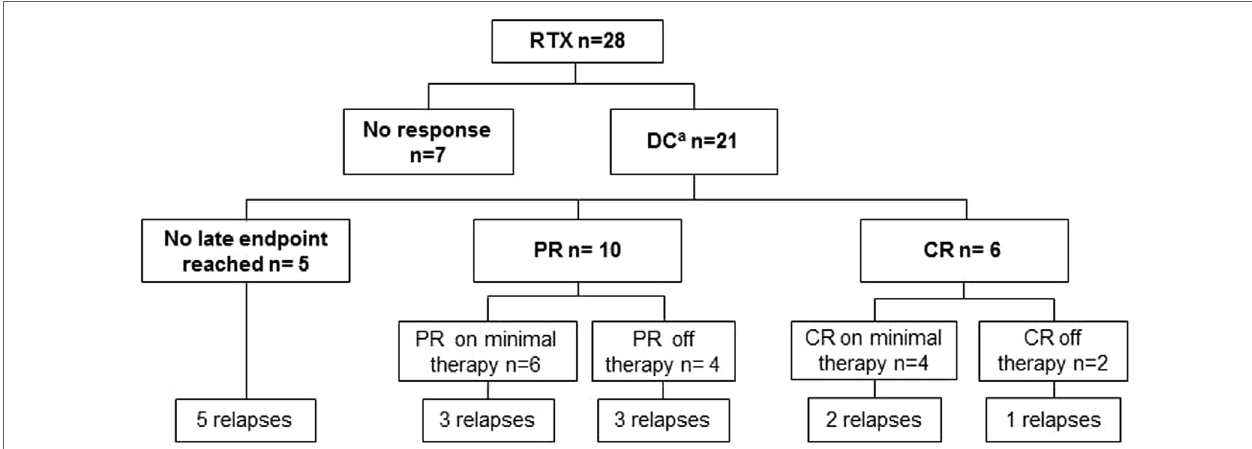
FigUre 3 | Flowchart of the effectiveness of RTX in pemphigoid patients, showing the highest endpoint reached after the first RTX cycle. RTX, rituximab; DC, disease control; PR, partial remission; CR, complete remission. a Two patients already achieved DC before RTX was administered.